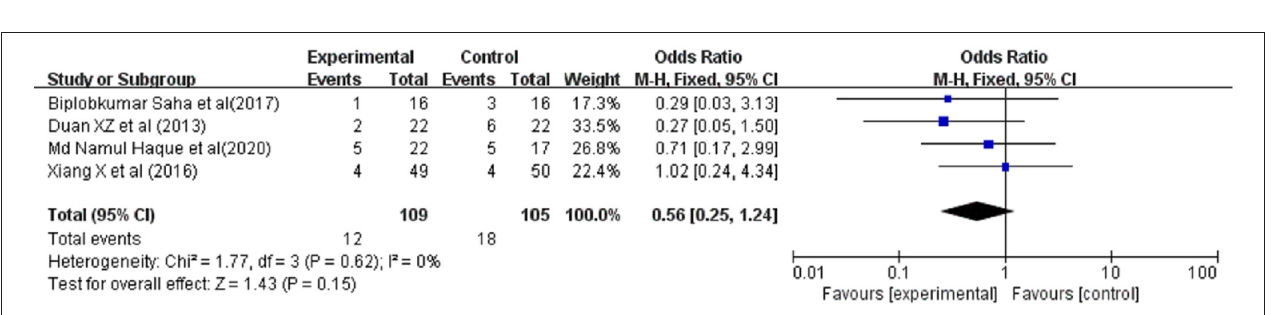
FIGURE 7 | Pooled estimate rate for Hepatorenal syndrome between patients with ACLF. Treated by G-CSF and